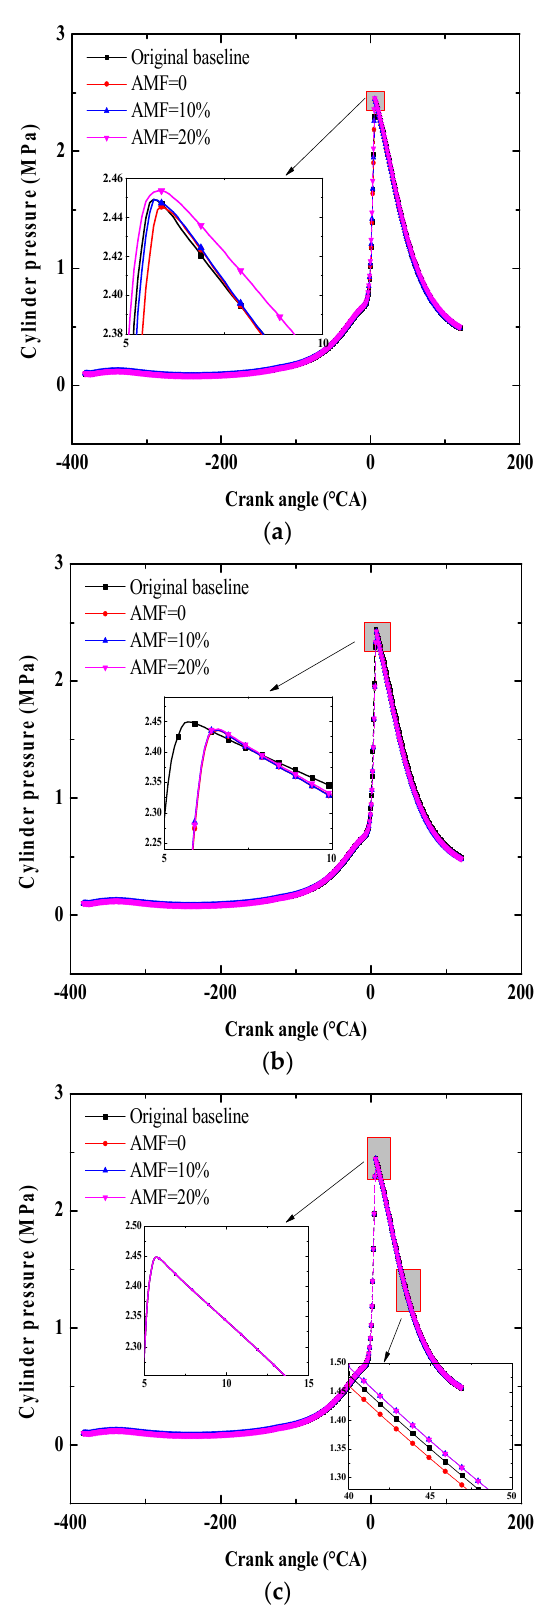
Figure 5. Cylinder pressure at different direct injection (DI) timings with variation of ammonia mass fraction (AMF): ( a ) DI timing = −105 °CA; ( b ) DI timing = 0 °CA; ( c ) DI timing = 40 °CA.